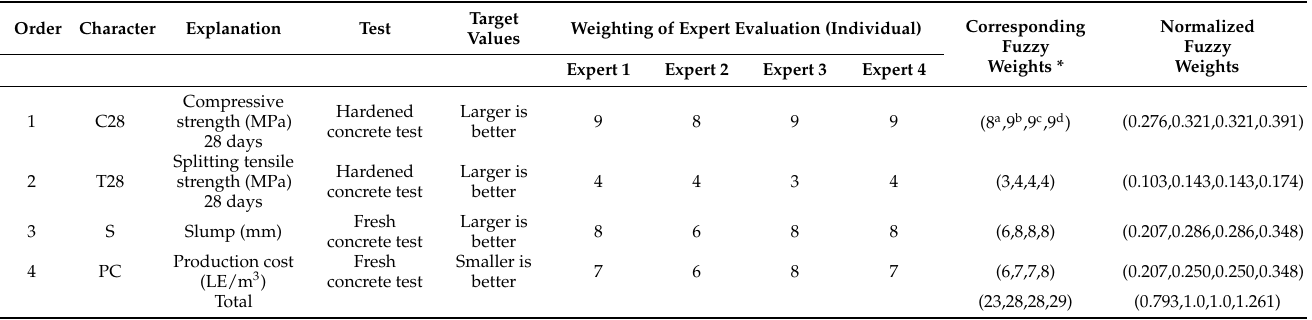
Table 5. The target values of each parameter for